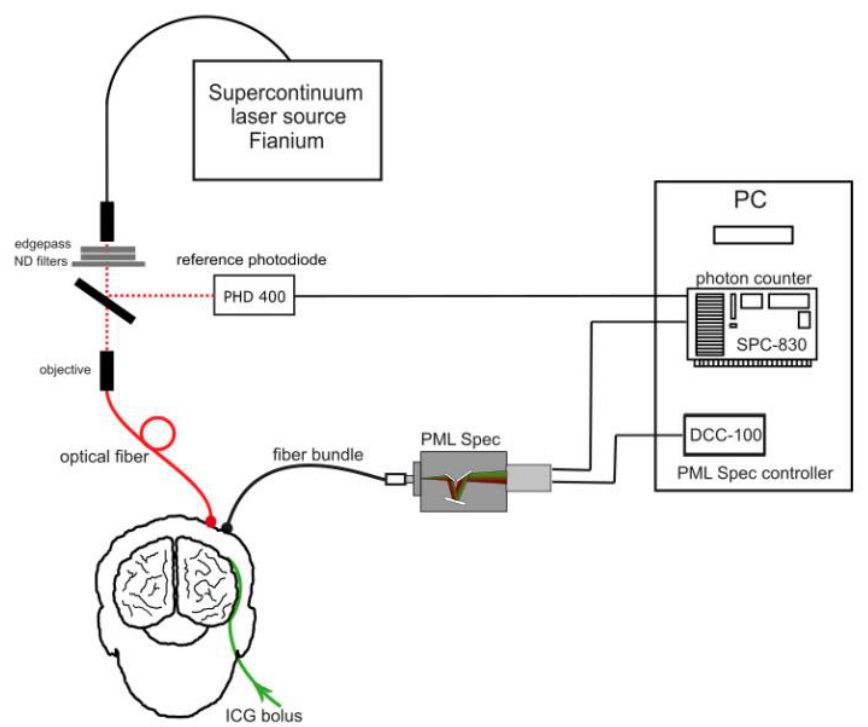
Figure 17. The setup for multiwavelength time-resolved diffuse reflectance measurements. Reprinted with permission from [100] © The Optical Society.